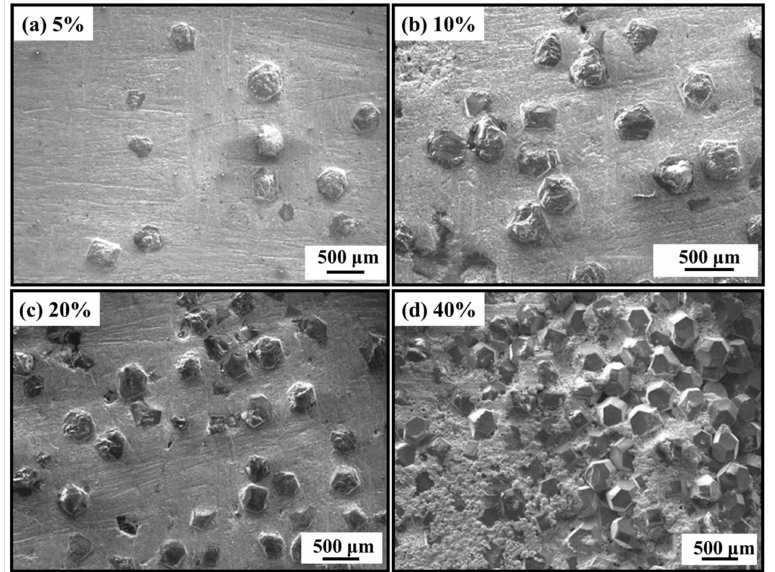
Figure 19. The wear morphology of the specimens with different contents of diamonds: ( a ) 5%, ( b ) 10%, ( c ) 20%, ( d ) 40%. Reprinted with permission from Ref. [78]. Copyright 2019, Hot Work- ing Technology.